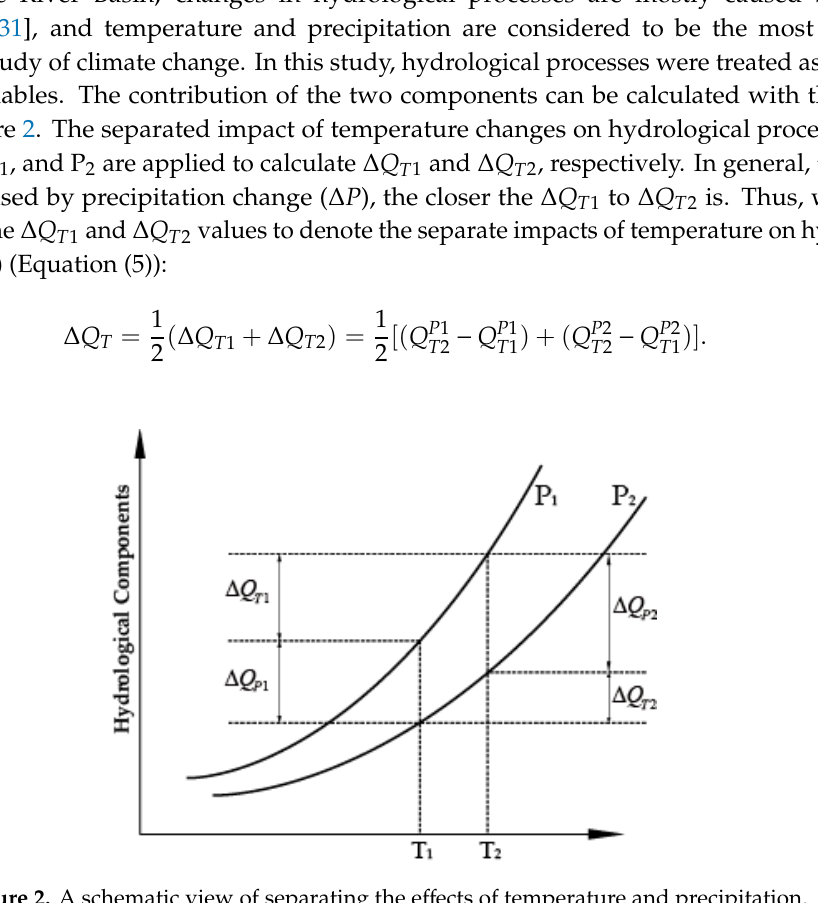
Figure 2. A schematic view of separating the effects of temperature and precipitation.